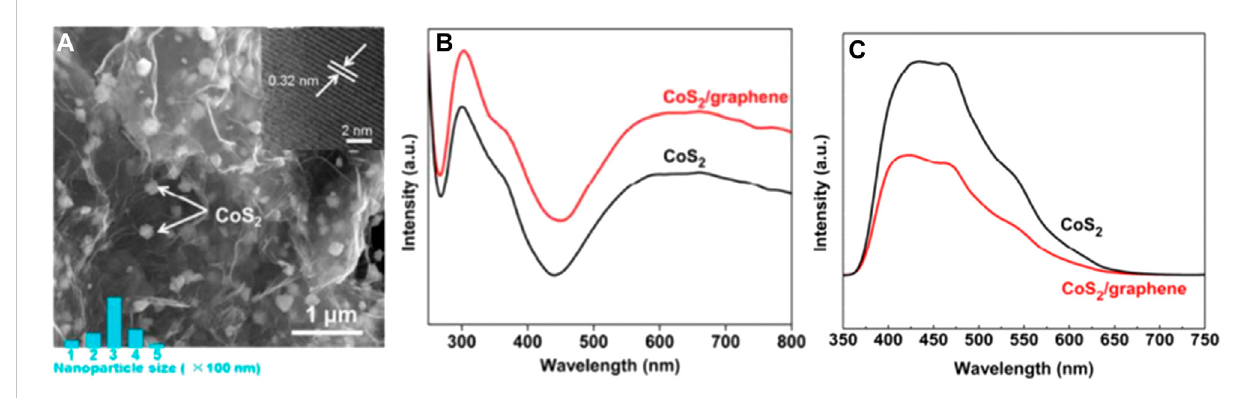
FIGURE 6 (A) Field emission scanning electron microscopy (FESEM) images of CoS 2 /graphene, (B) UV-vis diffuse re fl ectance spectra, and (C) photoluminescence spectra of CoS